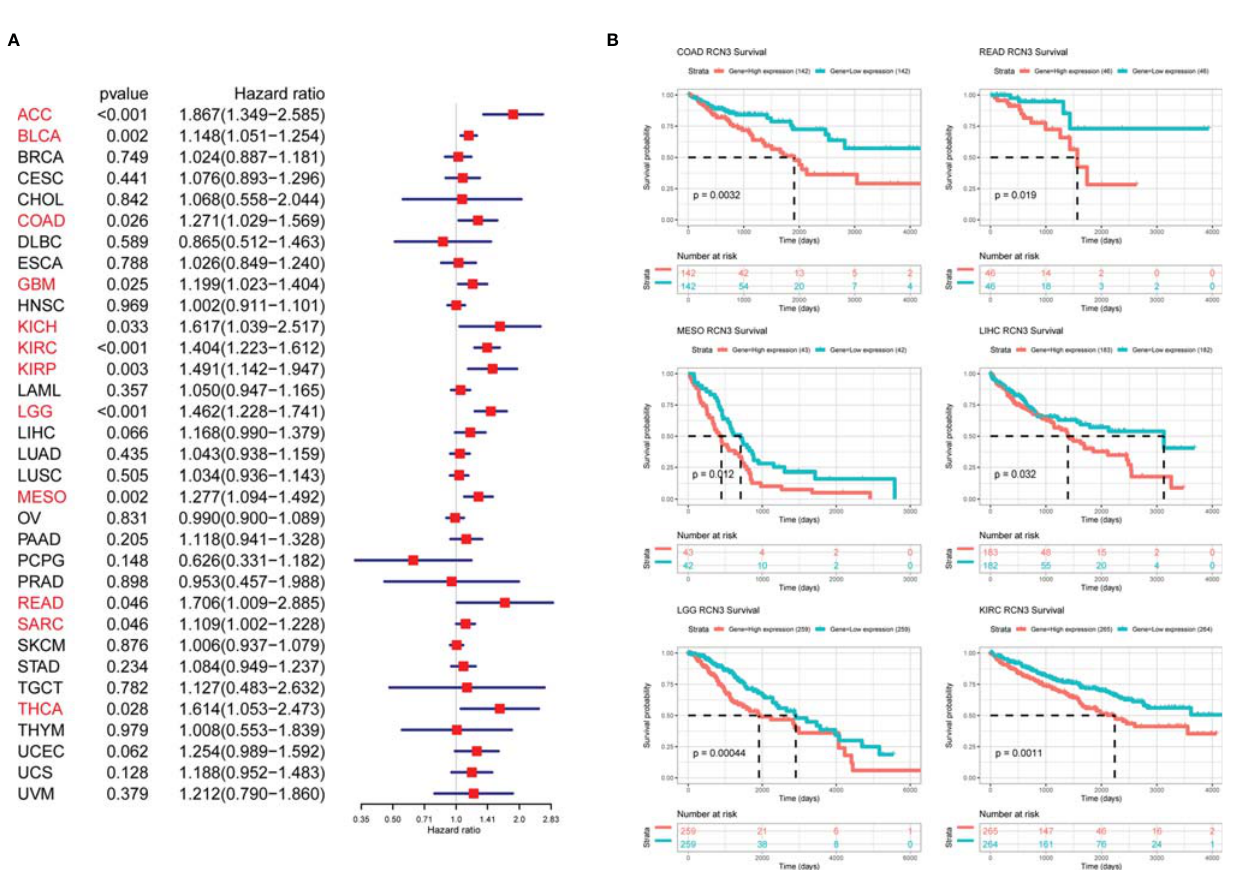
FIGURE 4 | Relationship of RCN3 expression with survival prognosis in pan-cancer. (A) Univariate Cox proportional-hazards regression used to quantify the relationship of RCN3 with overall survival. High RCN3 expression correlated with bad prognosis in ACC, BLCA, COAD, GBM, KICH, KIRC, KIRP, LGG, MESO, READ, SARC, and THCA (HR>1, p-value<0.05). (B) Kaplan-Meier curves showing higher expression of RCN3 was related to poor prognosis of OS in 6 cancer types. The survival curves with logrank p<0.05 are